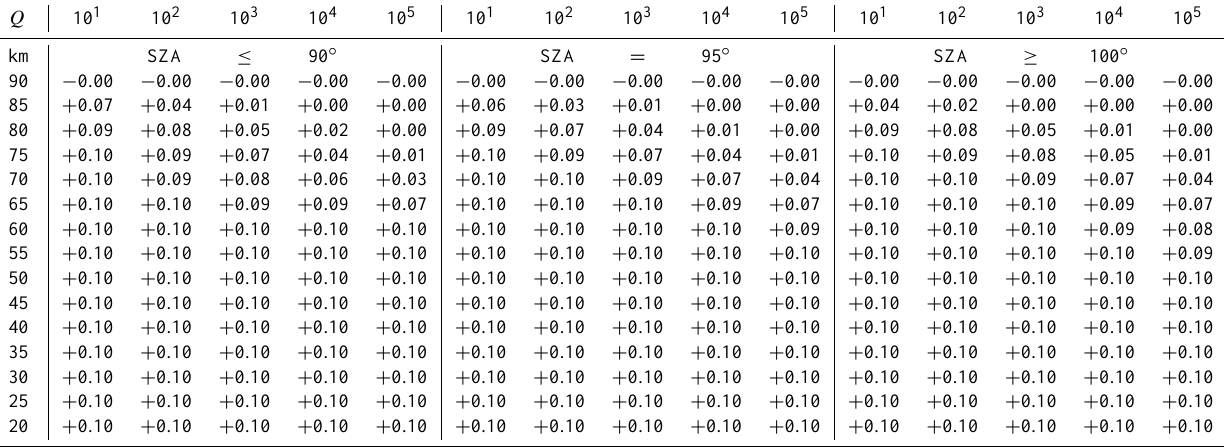
/Q for January SH. 2